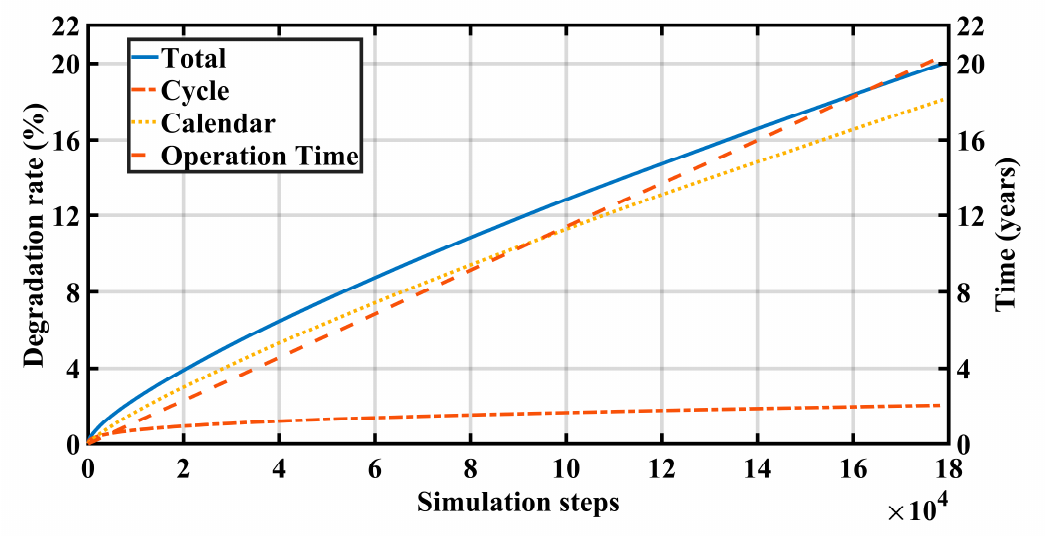
Figure 9. Degradation trends of lithium battery model 1.